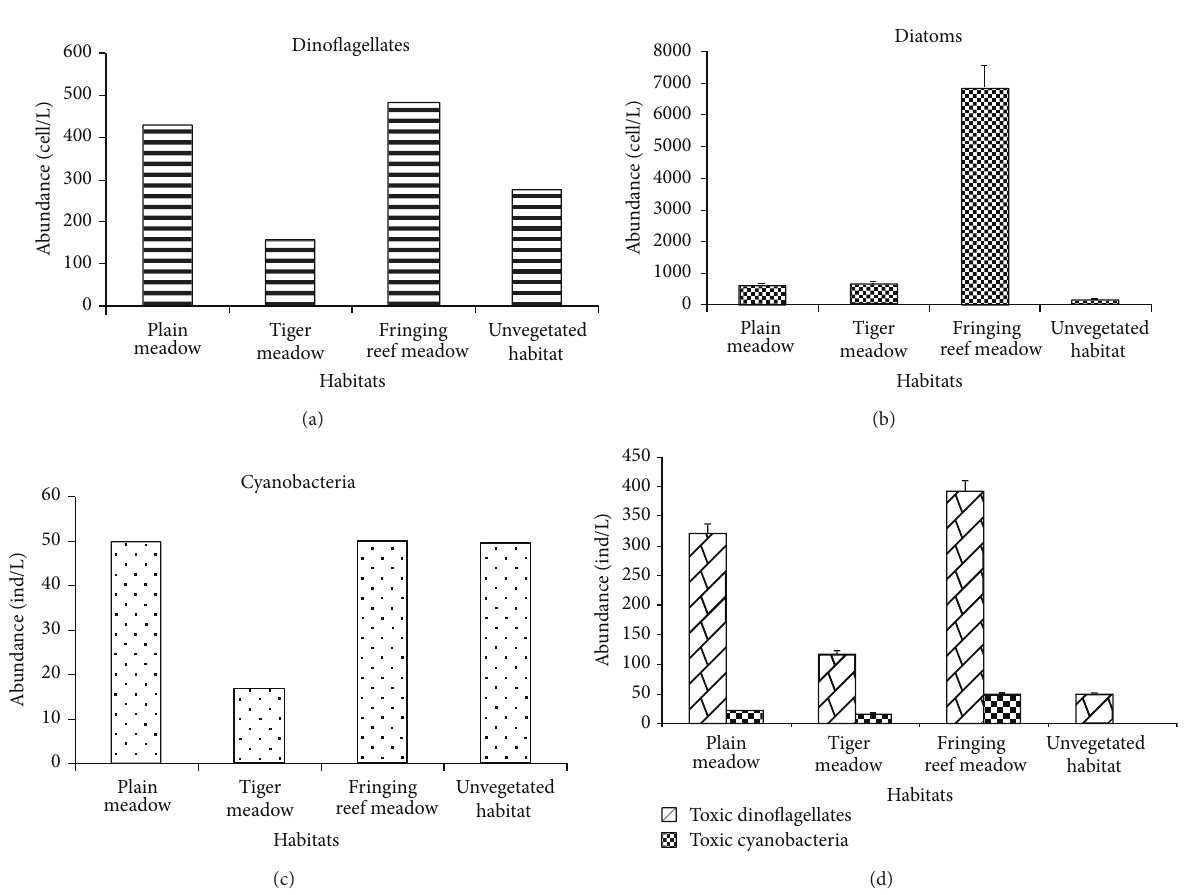
Figure 2: Average abundance of phytoplankton in water column in prospected